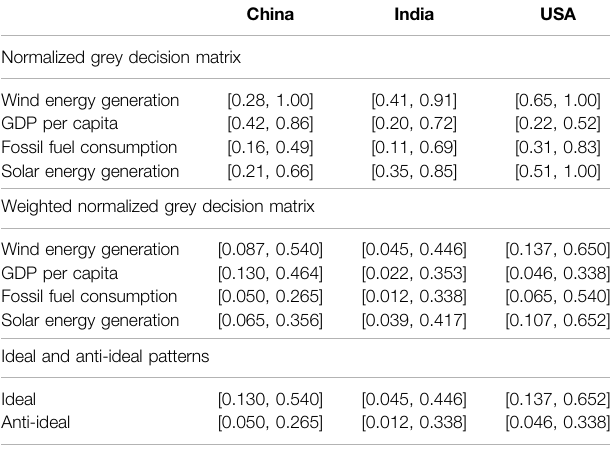
TABLE 7 | Estimated distances from the ideal and anti-ideal pattern.